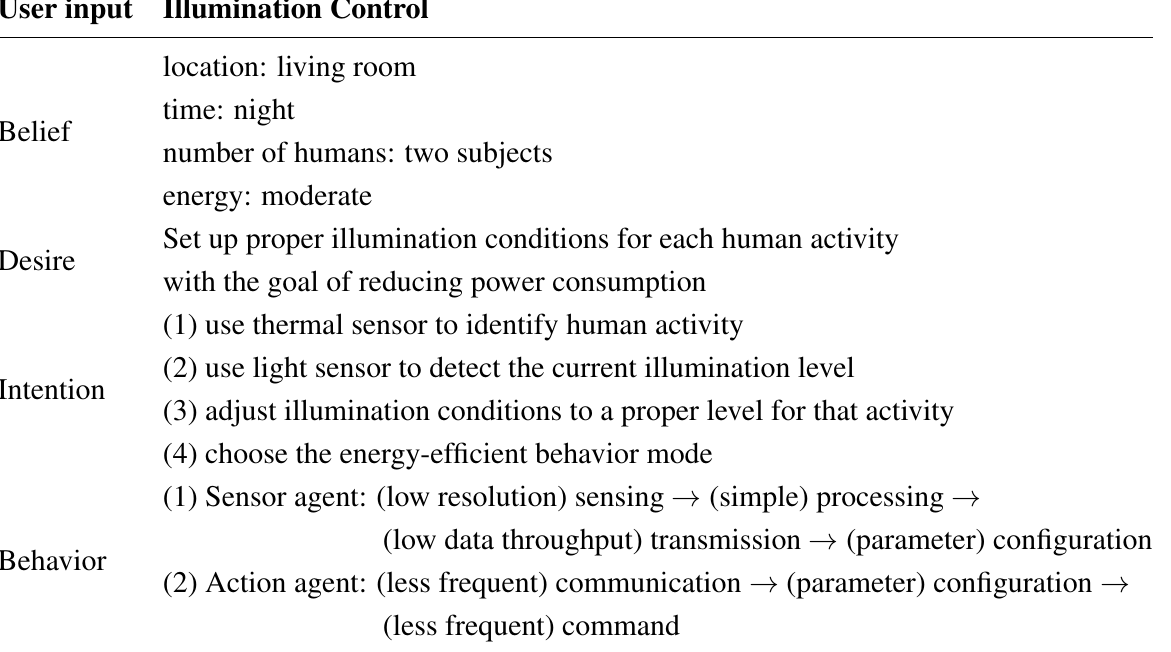
Table 2. belief, desire and intention (BDI) model-based sensing agent individual behavior for lighting